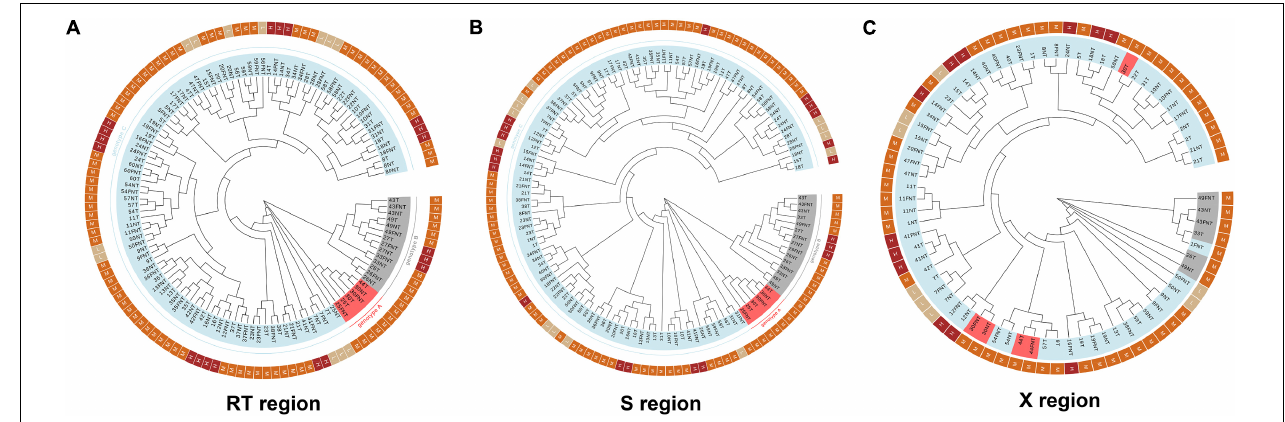
FIGURE 3 | Phylogenetic trees based on (A) RT, (B) S, and (C) X region of HBV in different patients of all tissues. In inner circle, the light blue color means genotype C, the gray color means genotype B, and the red means genotype A. In the outer circle, beige means the patients with low differentiated cancer cell. Orange means the patients with moderate differentiated cancer cells. Deep red means high differentiation group. RT, reverse transcriptase; T, tumor; NT, adjacent non-tumor; FNT, distal non-tumor.